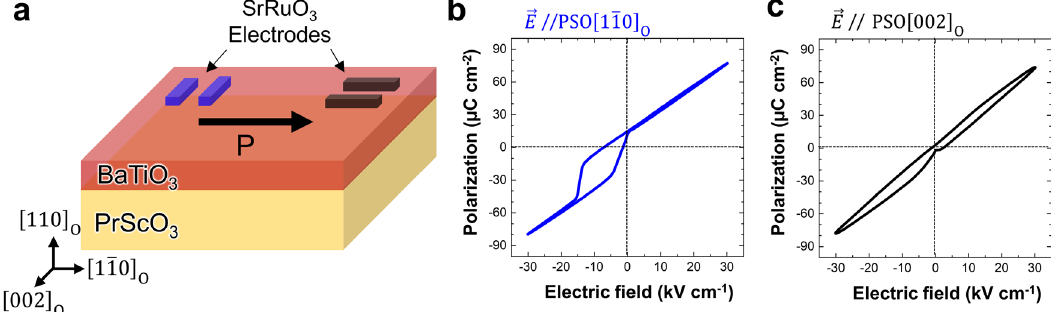
Fig. 4 In-plane polarization measurement versus electric fi eld. a Schematics depicting parallel electrodes on the BTO/PSO sample. The 10-nm-thick SrRuO 3 patterns which are oriented along two different directions with 50- μ m gap are used as electrodes for the measurements. b , c Room temperature hysteresis loop measurements for two parallel electrodes arrangements where the electric fi eld is applied parallel to PSO ½ 1 (cid:1) 10 (cid:2) O ( b ), and PSO ½ 002 (cid:2) O ( c ) directions,